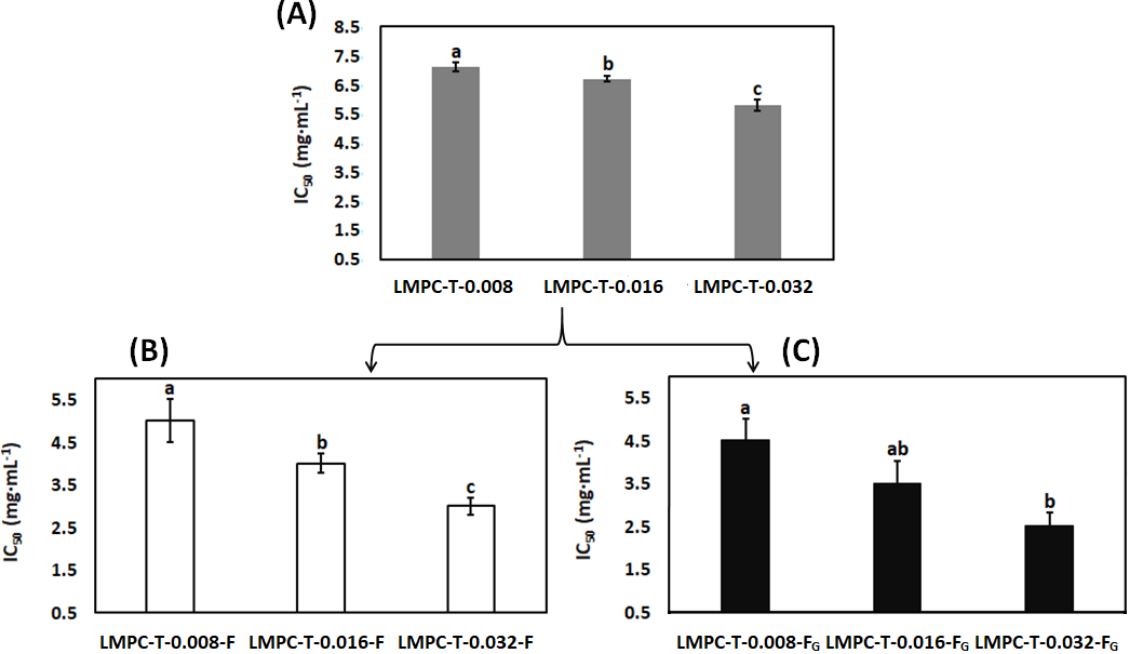
Figure 9. The value of IC 50 of LMPC-T ( A ), LMPC-T-F ( B ) and LMPC-T-F G ( C ). Results are represented with a mean value and standard deviation (± values) of three triplicate experimental results. In superscript, the dissimilar alphabet represents a significant difference between results.